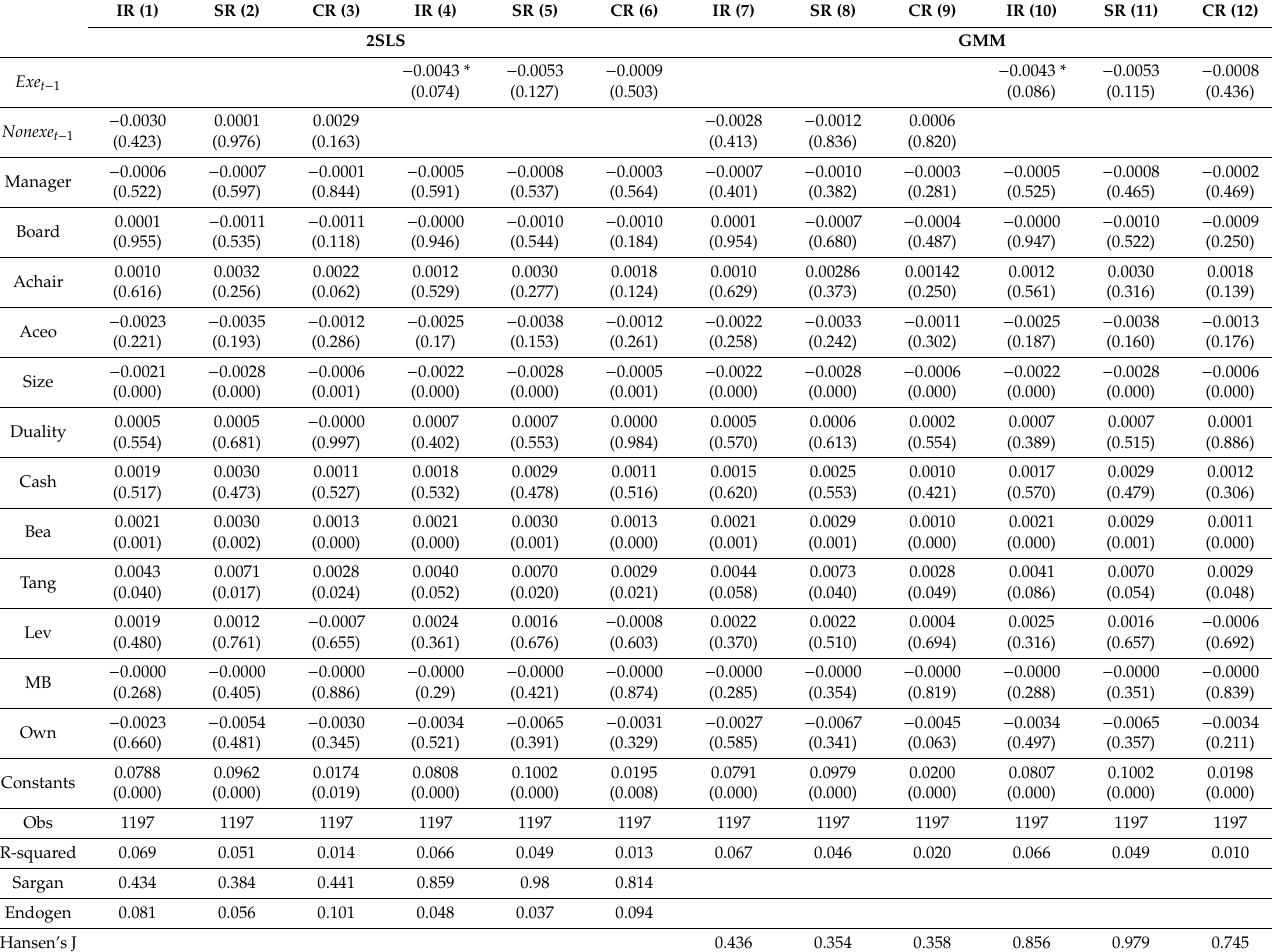
Table 6. The impact of female executive and non-executive directors onboard and downside